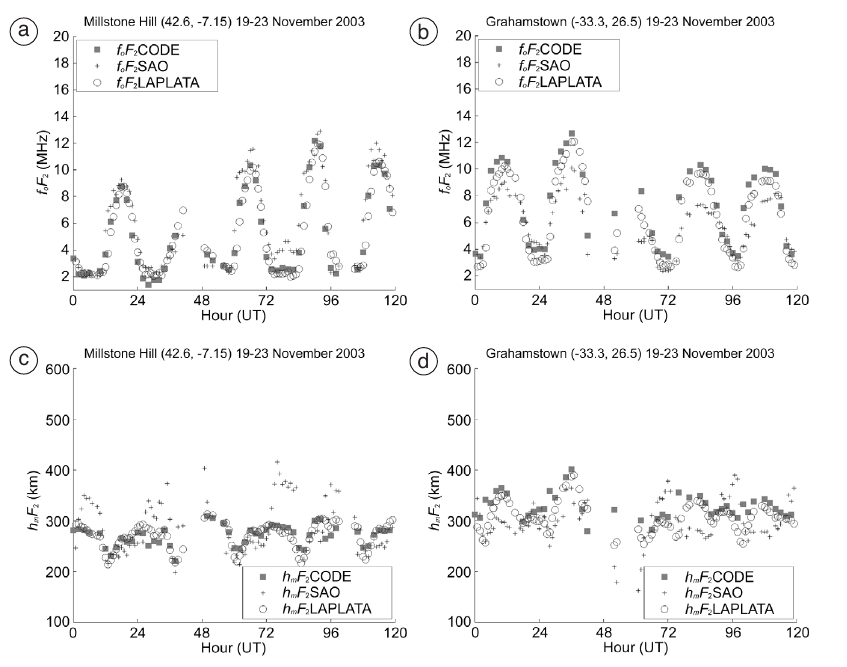
Fig. 3a-d. f o F 2 (a) and h m F 2 (c) for Millstone Hill (middle latitude Northern Hemisphere); f o F 2 (b) and h m F 2 (d) for Grahamstown (middle latitude Southern Hemisphere), during November 2003 (storm period).